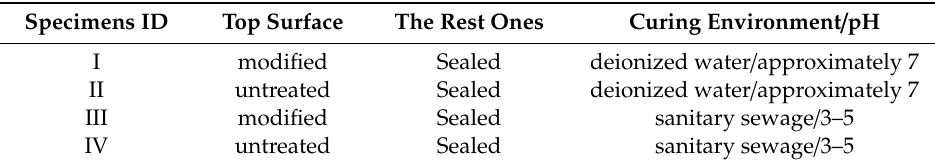
Table 2. Cement specimens design for durability